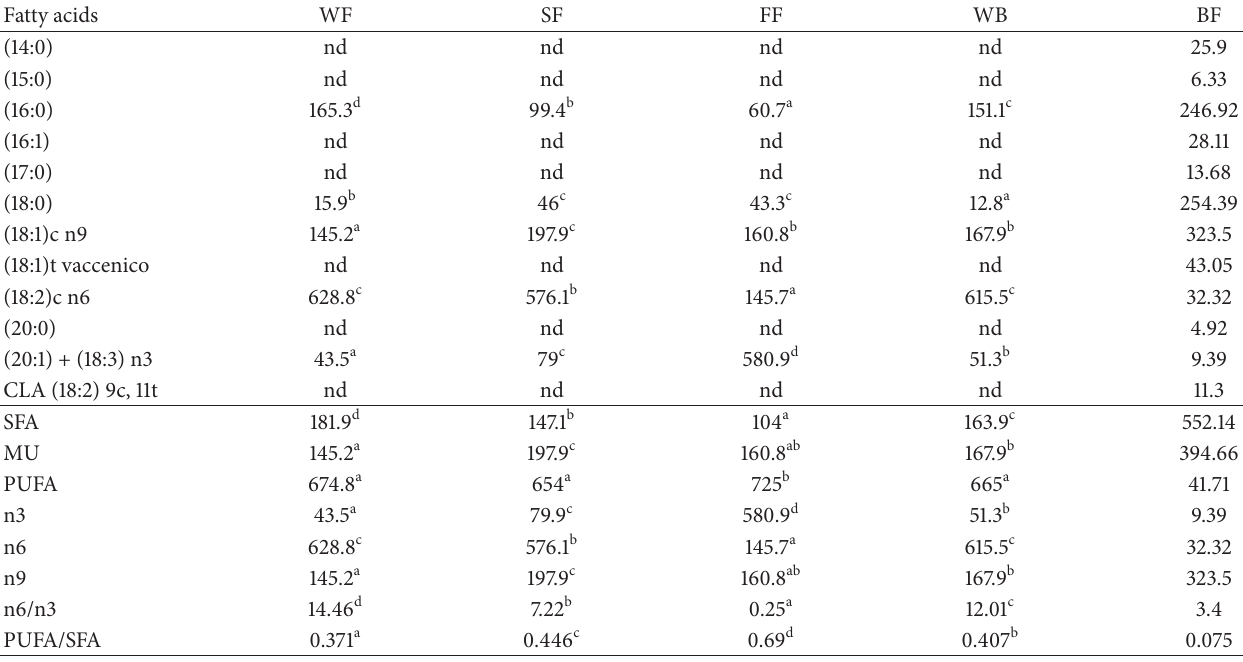
a Meanvalueswithdifferentlettersinacolumnaresignificantlydifferent( 𝑃 < 0.05